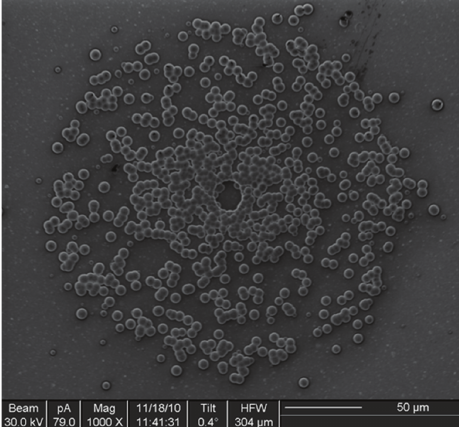
Figure 2: Focused ion beam (FIB) image of the rear of a test cell. Unwanted Ni plating can be seen around a rear point contact on an IJP PERC cell plated using electroless Ni